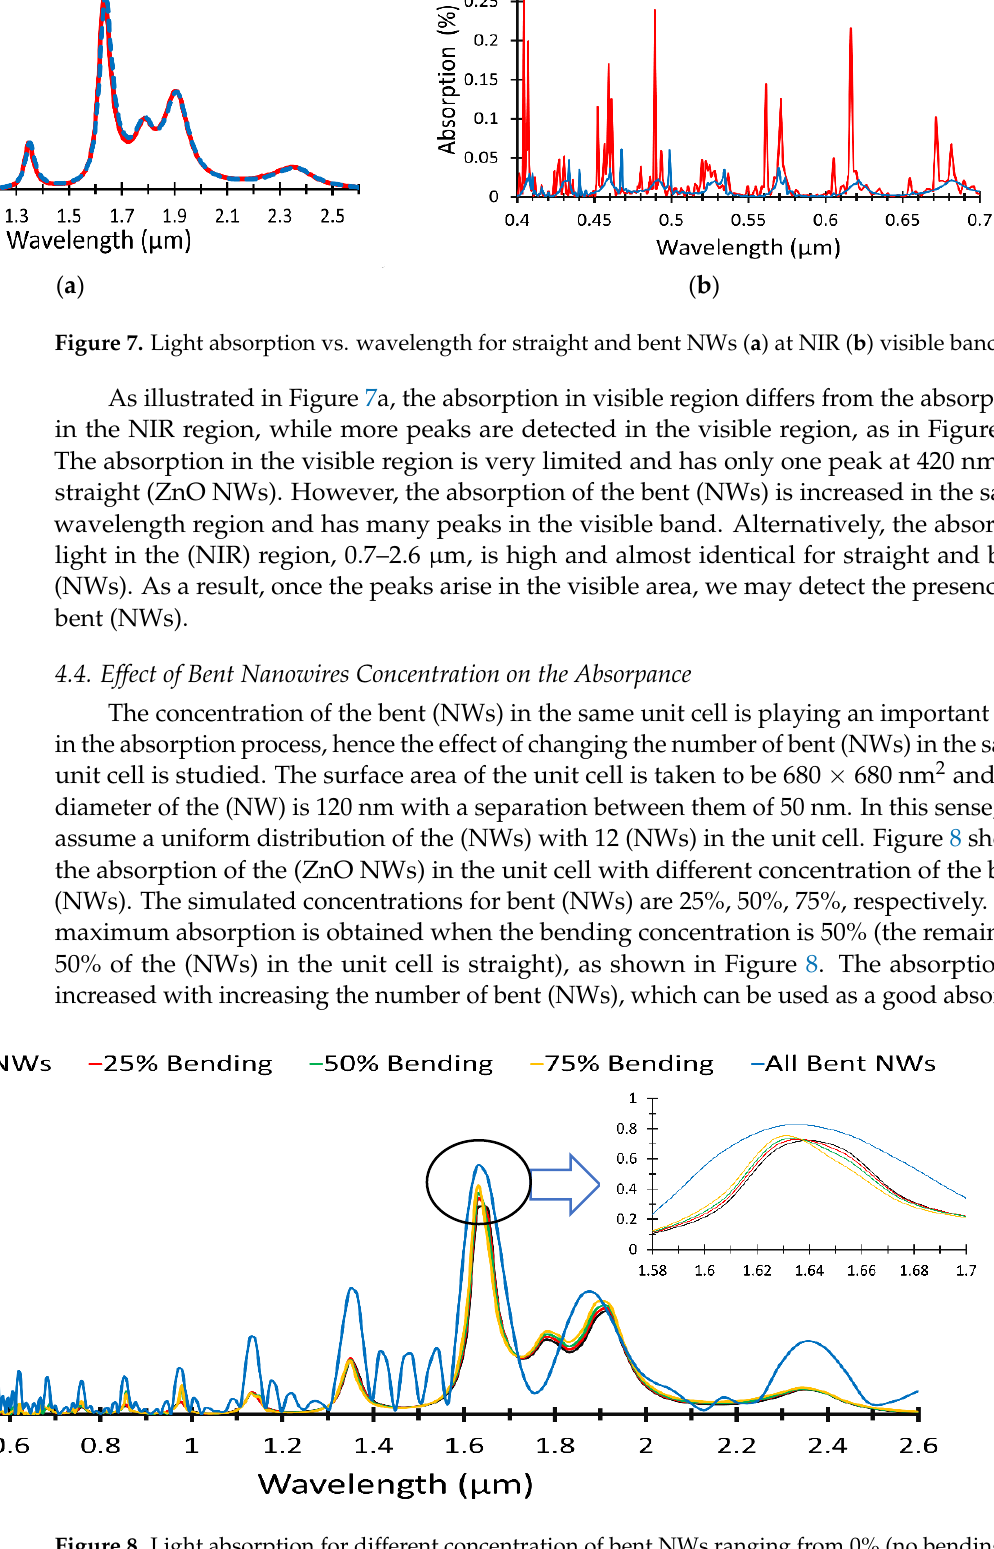
Figure 8. Light absorption for different concentration of bent NWs ranging from 0% (no bending) to 100% (NWs in the given simulation cell are all bent).